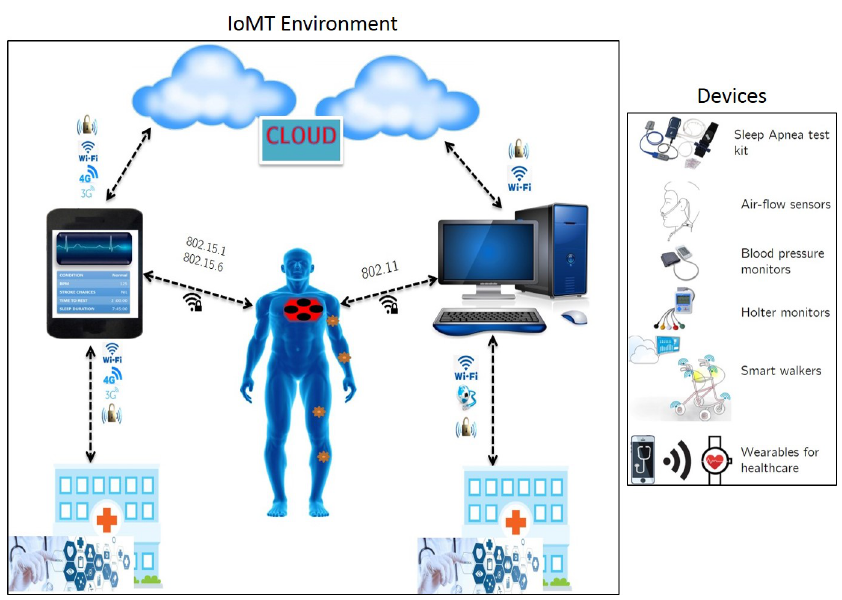
Figure 2. Connected Healthcare in an IoMT paradigm